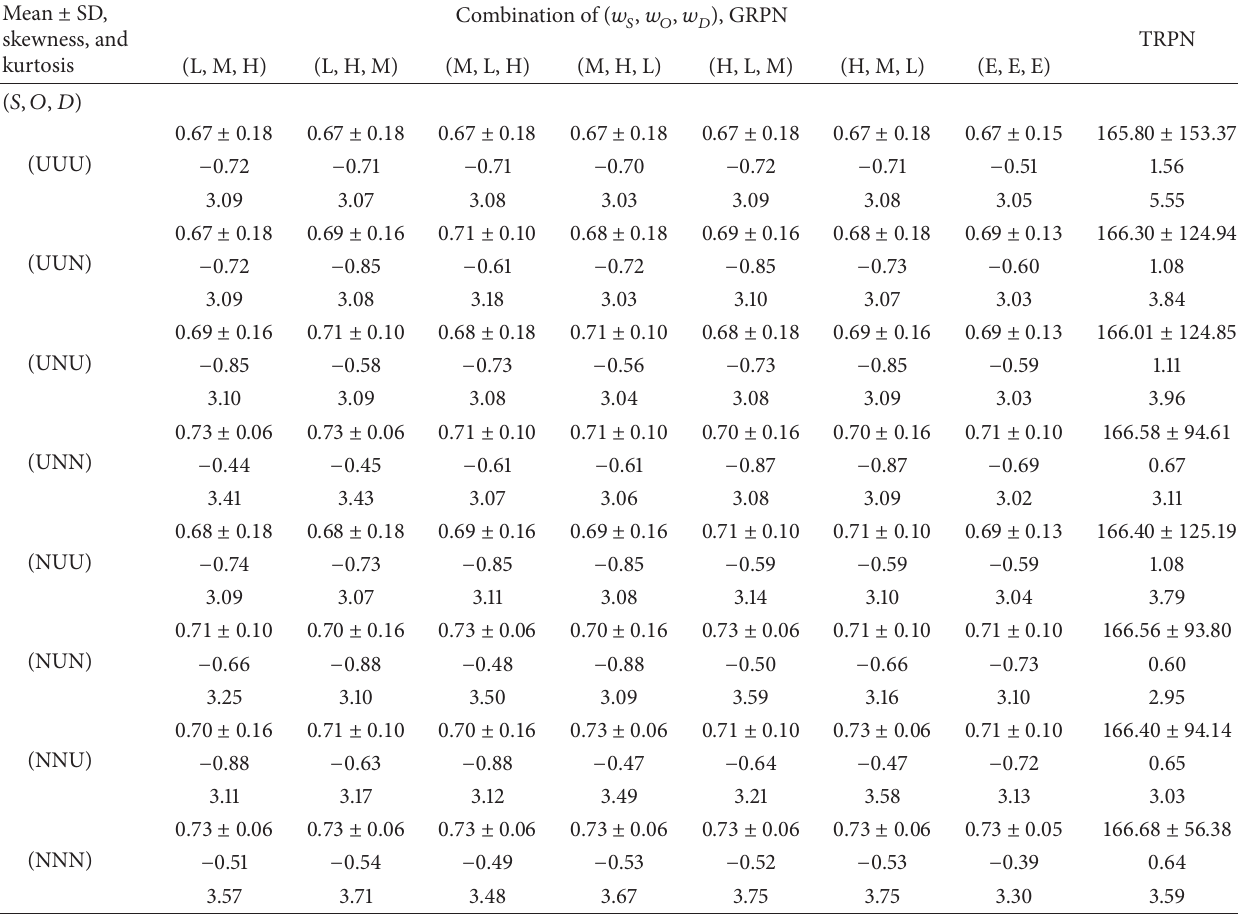
Table 7: Descriptive statistics of mean ± SD, skewness, and kurtosis.